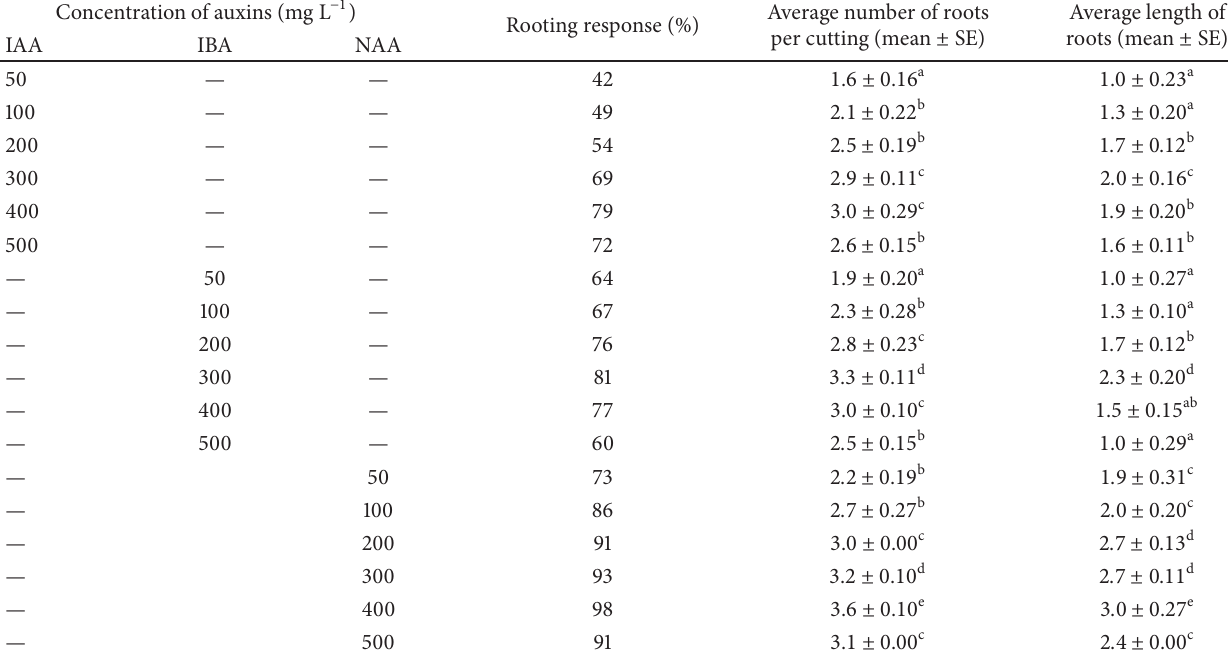
Table 2: The effect of auxins on rooting of C. guianensis stem cuttings. Concentration of auxins (mg L −1